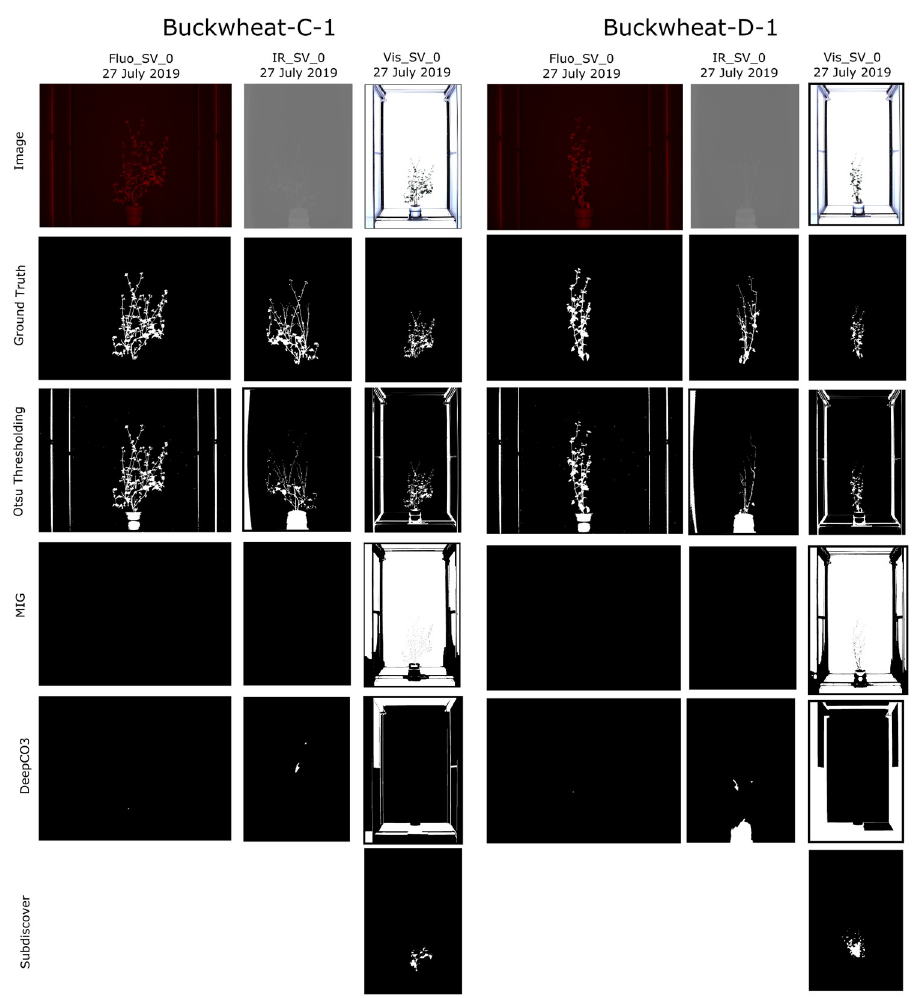
Fig 5. Qualitative performance examples of CosegPP ’s Buckwheat with three cosegmentation methods (DeepCO 3 , MIG, Subdiscover) and one plant phenotyping segmentation methods (Otsu Thresholding). Each binary mask produced is the output of each cosegmentation methods with CosegPP where the white pixels are the pixels for the identified object(s). Subdiscover was unable to produce a binary mask for Buckwheat-C-1 and Buckwheat-D-1 in the fluorescence and infrared